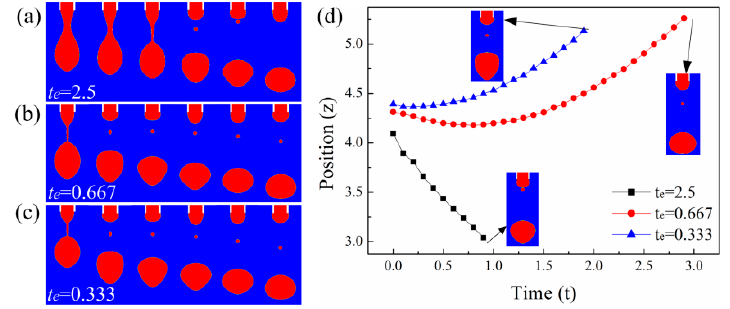
Figure 2. The satellite flight behaviors for liquids with CRTs of ( a ) 𝑡 (cid:3032) (cid:3404) 2.5 , ( b ) 𝑡 (cid:3032) (cid:3404) 0.667 , ( c ) 𝑡 (cid:3032) (cid:3404) 0.333 . The dimensionless time between adjacent images is 1. ( d ) The position of the satellite drops with time for liquids with different CRTs. The other parameters are 𝑂ℎ (cid:3404) 0.05 , ɸ (cid:3404) 6 , 𝑄 (cid:3046) (cid:3404) 0.314 , 𝜀 (cid:3045) (cid:3404) 50